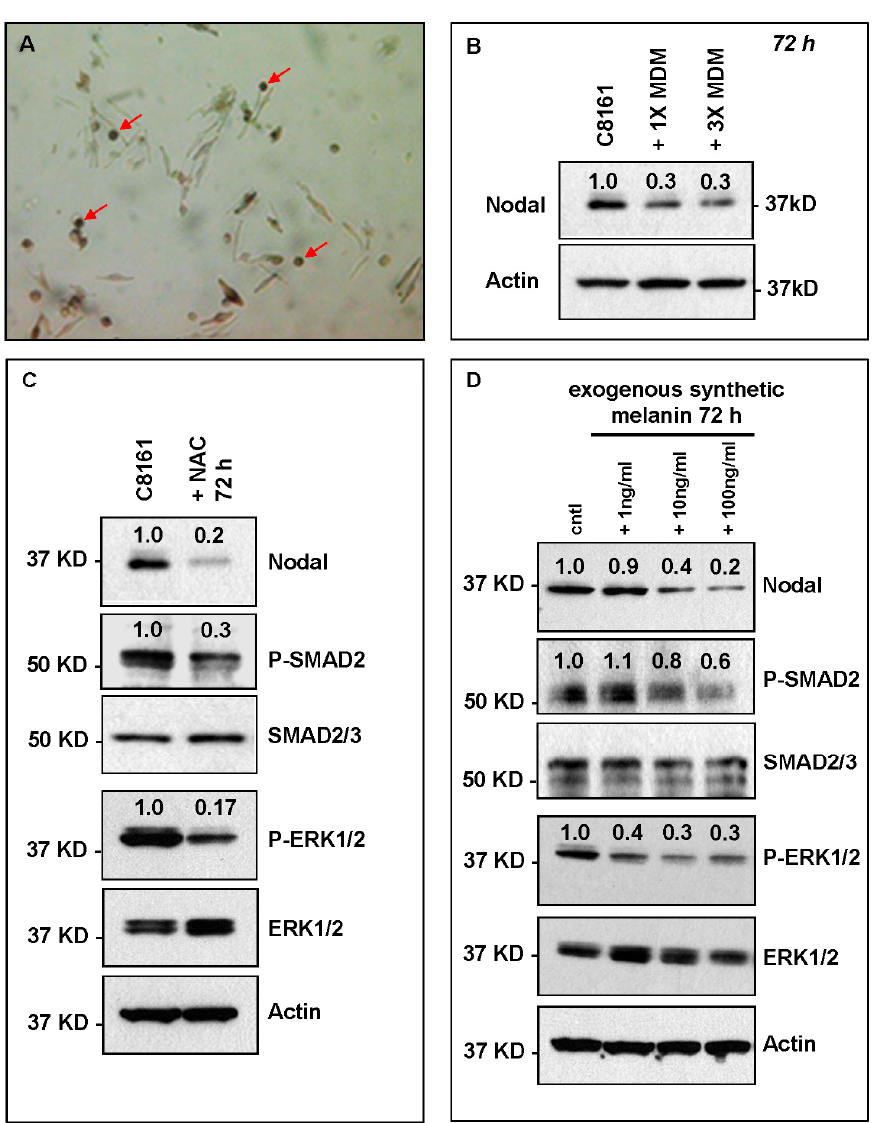
Figure 5. HeMn melanocyte derived melanosomes (MDM) affect Nodal expression and signaling components in C8161. ( A ) Microphotograph (40× original magnification) shows MDM containing globules (red arrows) produced by HeMn melanocytes; ( B ) C8161 melanoma cells treated with different concentrations of MDM collected from HeMn melanocytes showed reduction in Nodal expression compared to untreated control C8161 cells. To mimic the anti-oxidant effect of free radical scavengers contained in MDM, C8161 cells were treated with N -acetyl- L -cysteine (NAC) known to generate the anti-oxidant, glutathione; ( C ) Western Blot analysis show that treatment of C8161 melanoma cells with 5 mM NAC resulted in reduced levels of Nodal, P-SMAD and P-ERK1/2 compared to untreated control C8161 cells; ( D ) Treatment of C8161 cells with synthetic melanin, also known to have anti-oxidant properties, resulted in a dose-dependent reduction of Nodal, P-SMAD and P-ERK1/2 levels compared to untreated control C8161 cells. Numbers above WB bands represent densitometric units, normalized to actin loading control, total SMAD2/3 or total ERK1/2, as appropriate, relative to control.